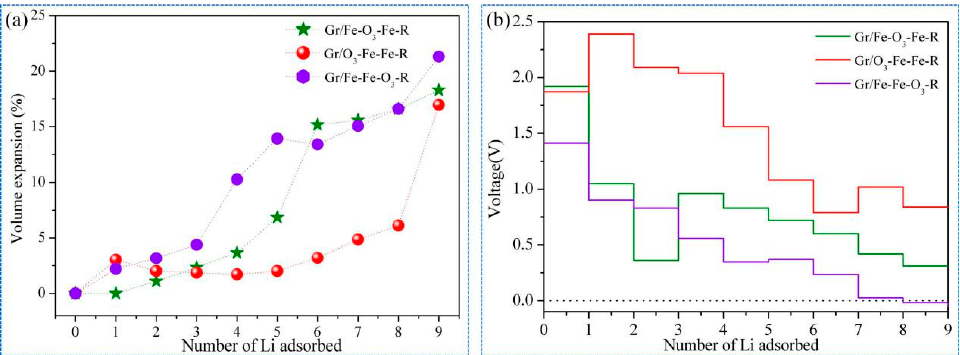
Figure 4. ( a ) Volume expansion ( Ve ) and ( b ) voltage figure versus number of Li for the Li n (Gr/Fe-Fe-R), and Li n (Gr/Fe-Fe-O 3 -R) configurations.